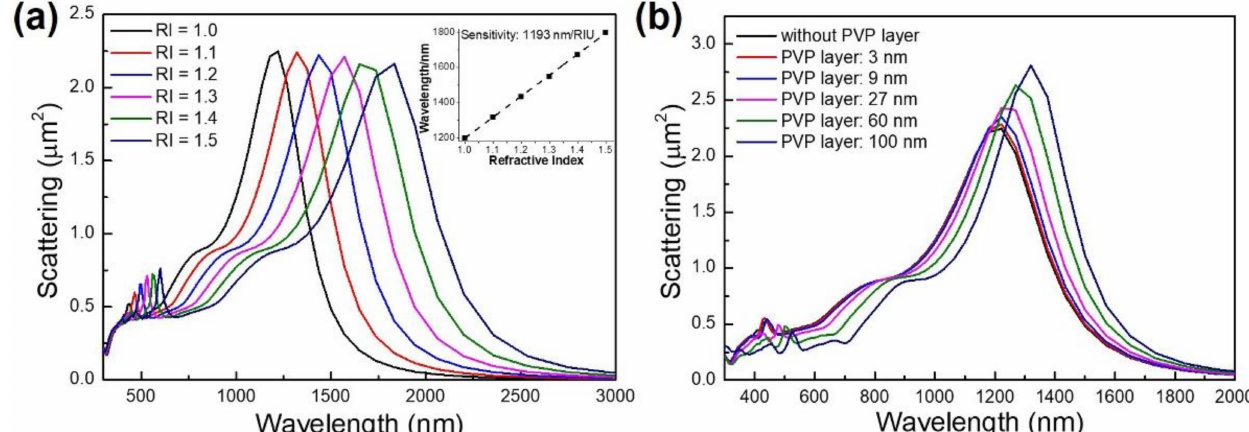
Figure 5. The influence of ambient medium and polyvinylpyrrolidone (PVP) coating on the surface plasmon resonance of a large-size Ag nanobar. ( a ) The simulated scattering cross-section of a single silver nanobar ( l = 900 nm, w = t = 200 nm) in different ambient medium with various refractive indexes (RI = 1.0, 1.1, 1.2, 1.3, 1.4, 1.5) at an incident angle ( θ = 0 ◦ ). The inset shows the relationships between maximum resonance wavelength with the refractive index of the surrounding medium.